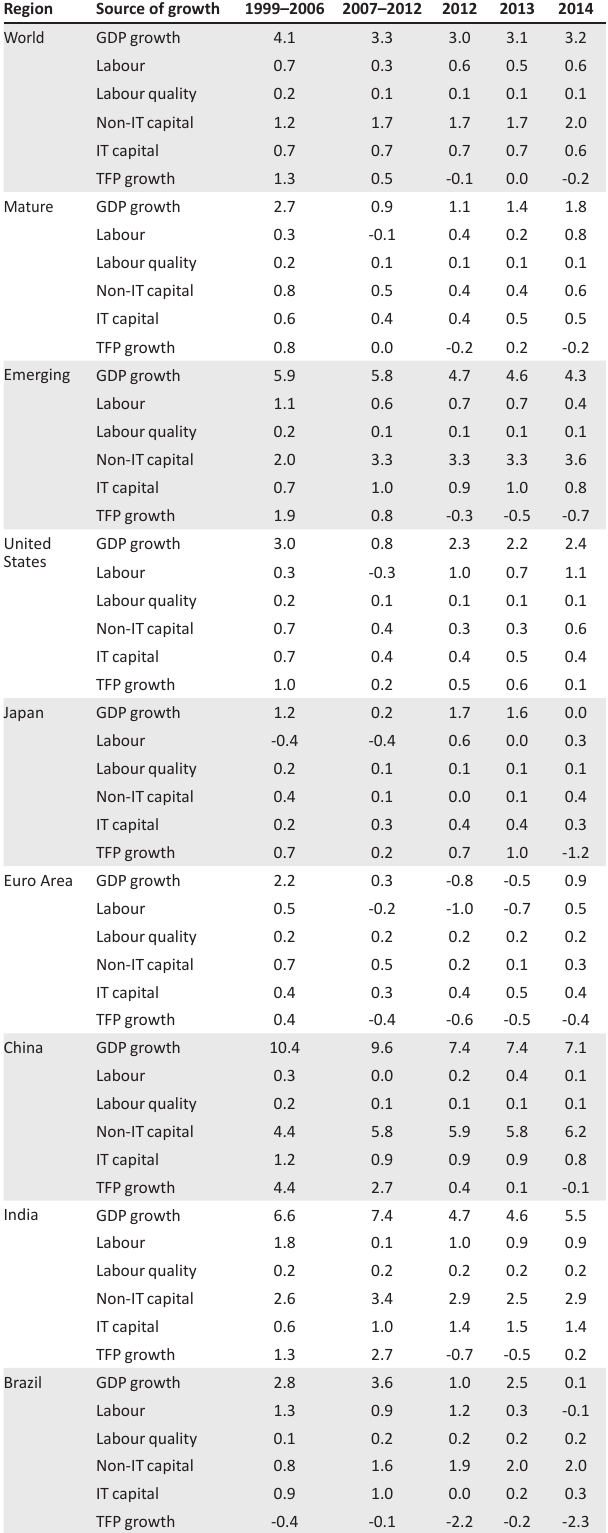
TABLE 1: Contributions of sources of growth to aggregate GDP growth, major regions,